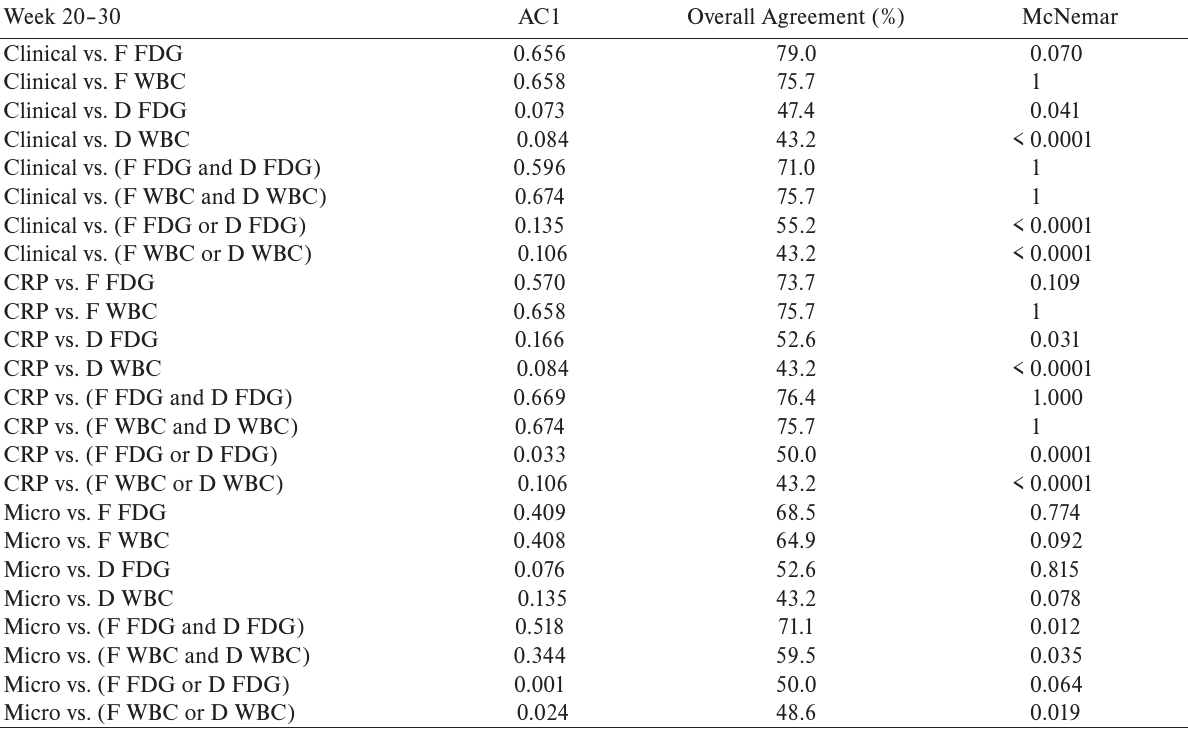
table 2b. Evaluation of agreement between reference parameters and diffuse or focal 18 F-FDG PET/CT and 99m Tc-HMPAO-WBC SPECT/CT findings at 20 to 30 weeks after surgery.